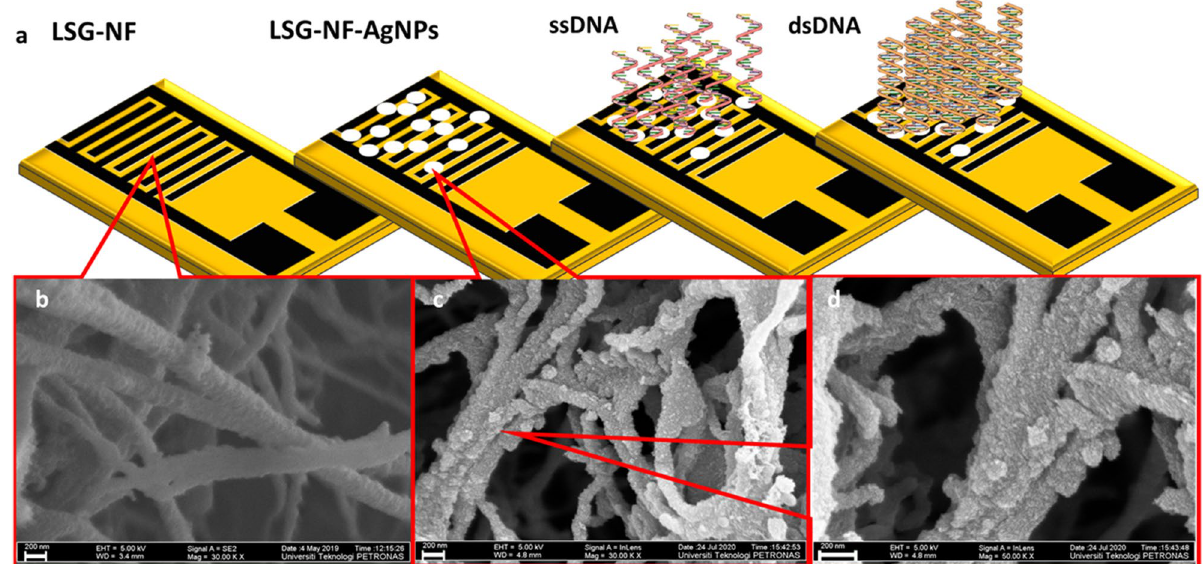
Figure 1. ( a ) Schematic diagram illustrating the process involved in the fabrication of LSG-NF-AgNPs DNA bioelectrode. ( b ) Low-magnification FESEM image showing smooth hair-like structure of synthesized LSG-NF: